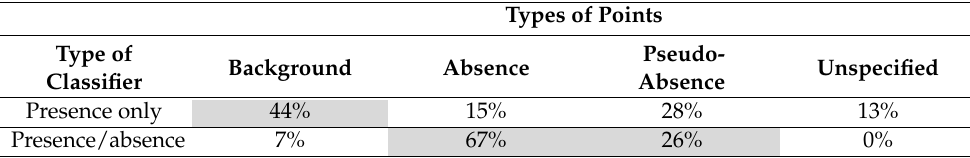
Table 6. Percentages of studies reviewed that used given types of points for presence-only or presence/absence classifiers. Gray cells indicate correct types of points for each type of classifier. Types of Points Pseudo- Type of Background Absence Classifier